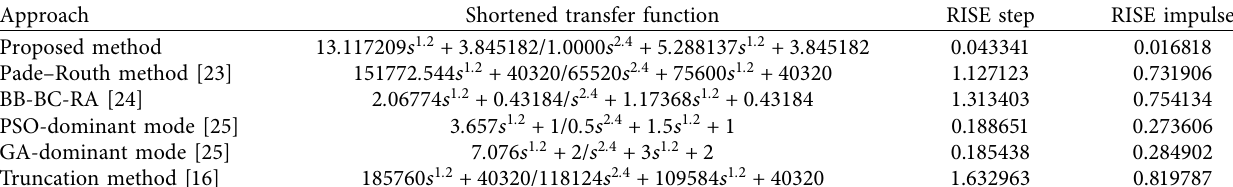
Table 1: Shortened transfer function and RISE values of step and impulse for diferent methods.